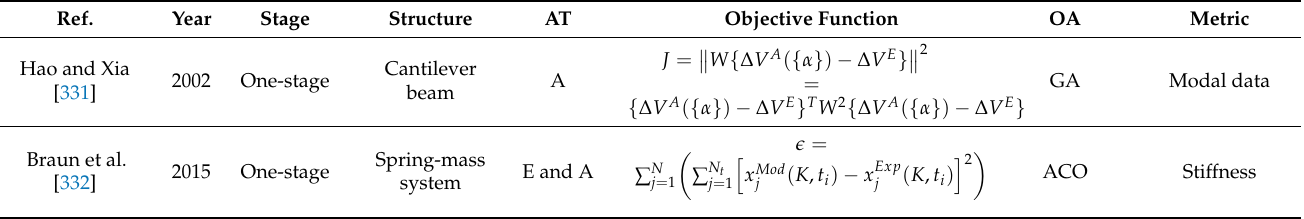
Table 19. Applications of optimization algorithms in SHM methods. (Note: E: Experimental ap- plication, A: Analytical application, One-stage: One-stage damage detection method, Multi-stage: Multi-stage damage detection method, AT: Application type; OA: Optimization algorithm).